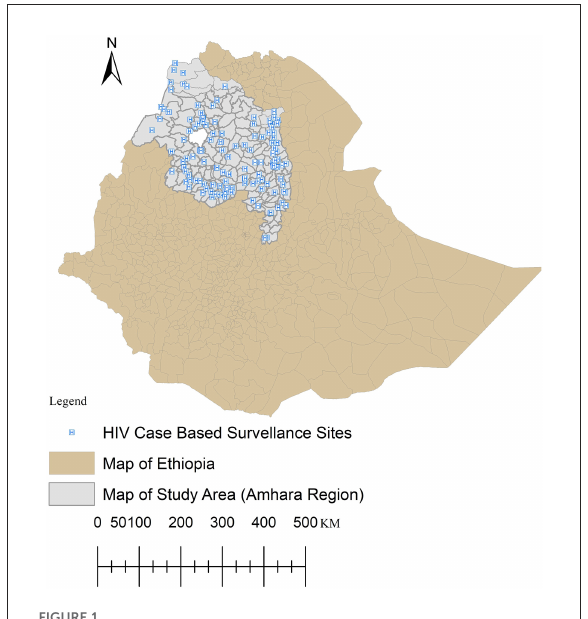
FIGURE1 Distribution of HIV case-based surveillance sites in the study area, northern